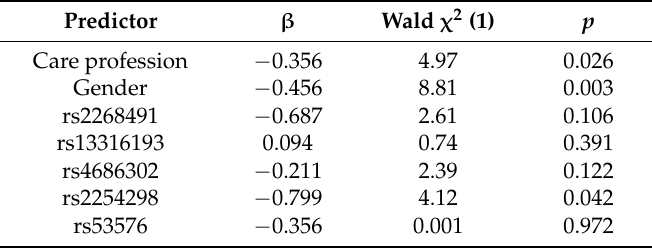
Table 3. Test of model effects Type I, that is, parameter estimates, dependent variable AES.